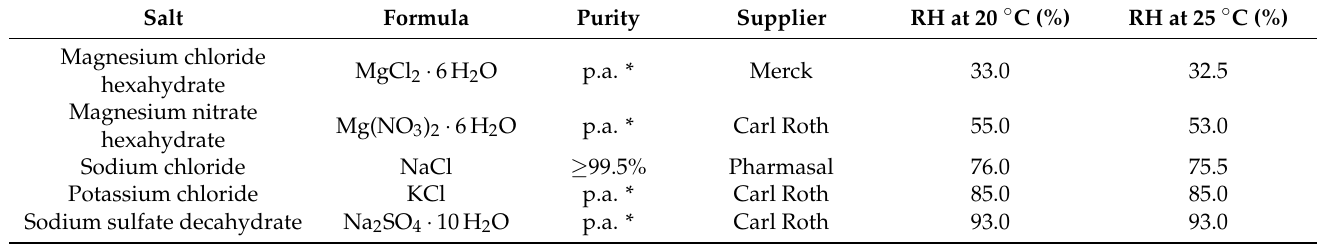
Table 1. Salts required for the experiments described below, their purity and supplier, as well as their equilibrium relative humidity (RH) at 20°C and 25°C when used for the saturated salt solutions